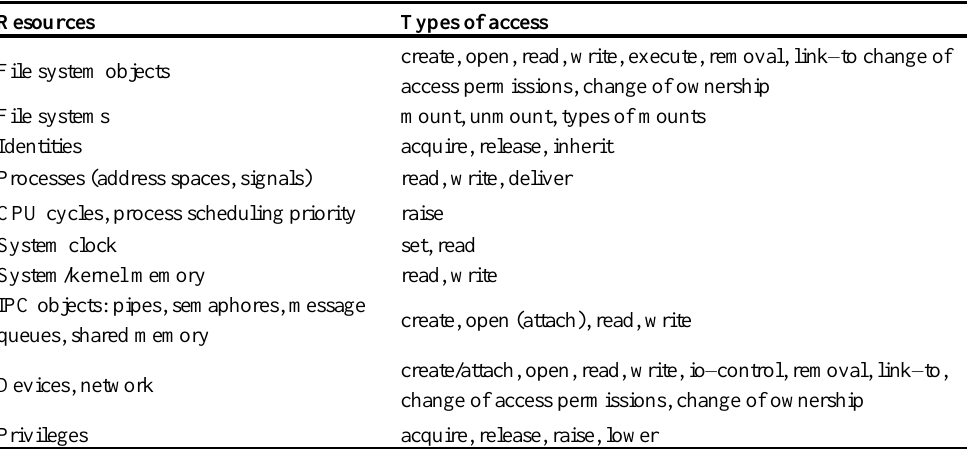
Table 2. 72 System calls are considered harmless in the host-based detection